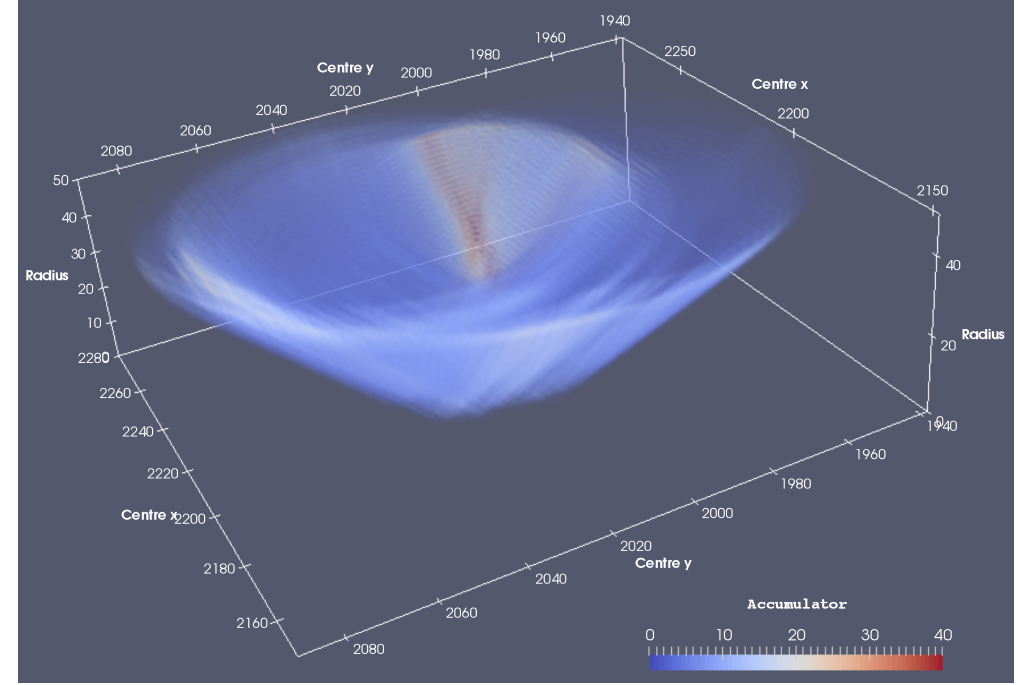
Figure 2. 3D parameter space transformed from a single tree stem cross section image. The three axis consist of the parameters x centre coordinate, y centre coordinate and radius. The maximum accumulator value defines the best circle